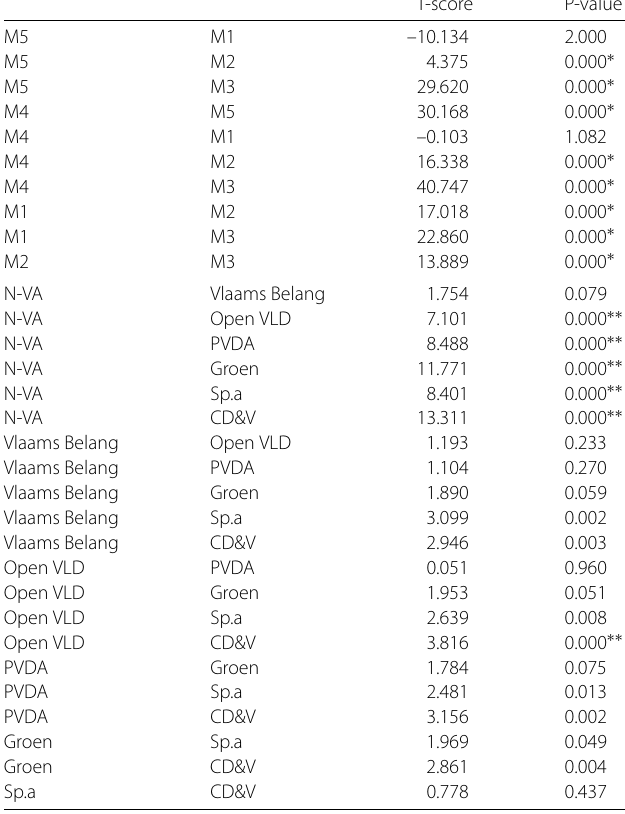
Table 7 Results for the corrected paired t-tests for party